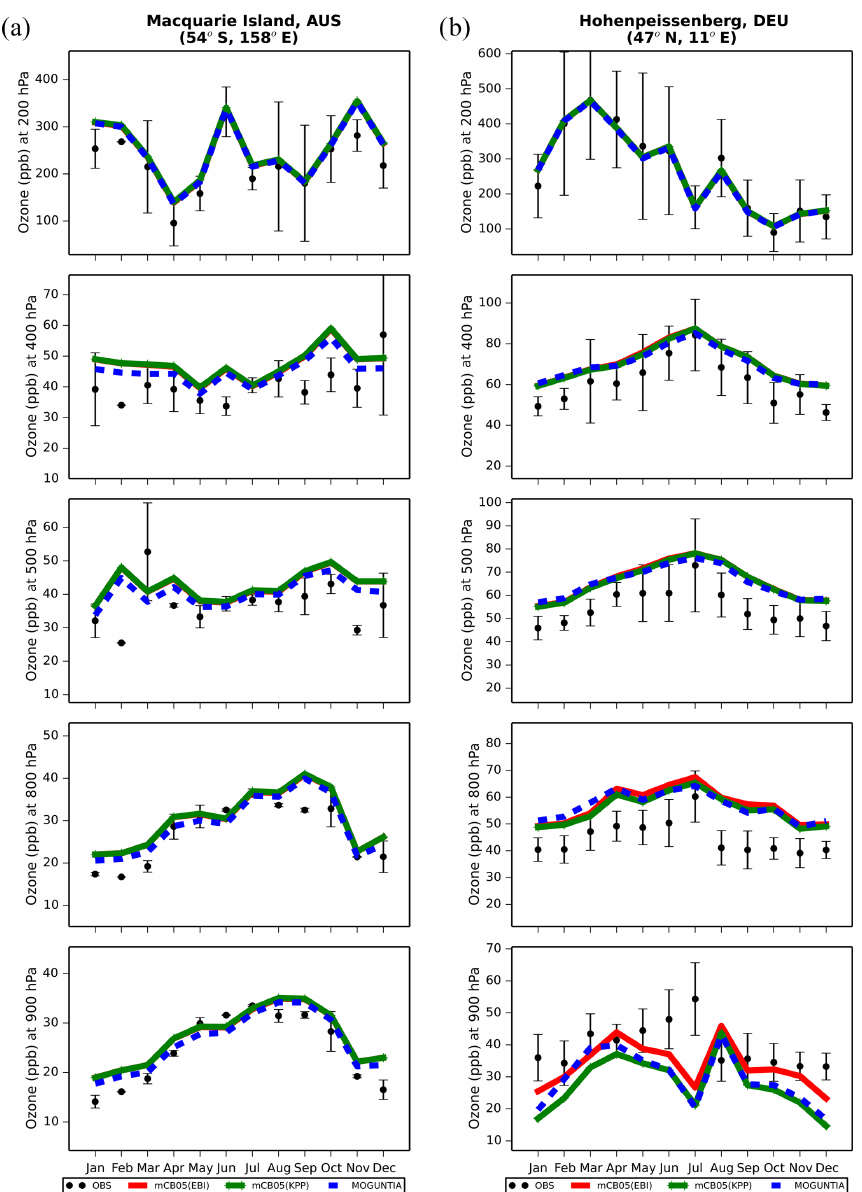
Figure 6. Monthly mean comparison of TM5-MP O 3 (ppb) against sonde observations (black dots; mean and standard deviation) at (a) Hohenpeissenberg and (b) Macquarie Island for different pressure levels (900, 800, 500, 400, 200hPa) for the two chemistry schemes, mCB05(KPP) (green line) and MOGUNTIA (blue line), using colocated model output for 2006 sampled at the measurement times; error bars indicate the standard deviation in the monthly means. For comparison, the results of mCB05 with the EBI solver (red line) are also